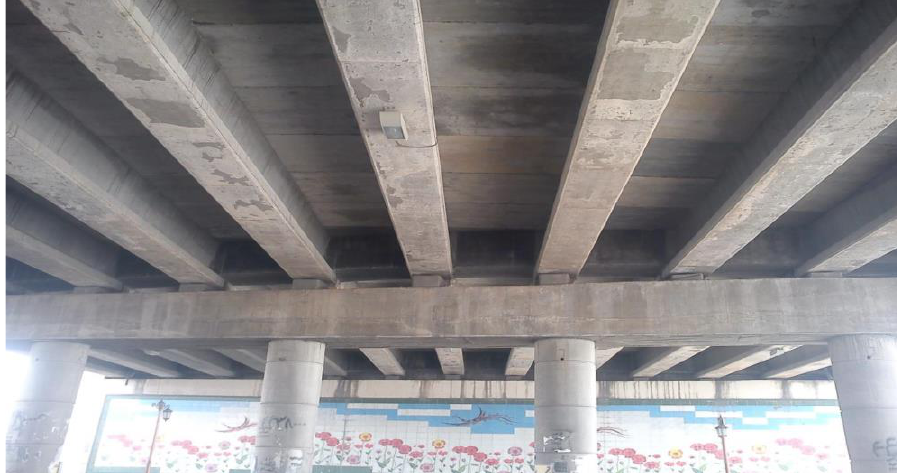
Figure 6. The structure of the bridge No. 1.